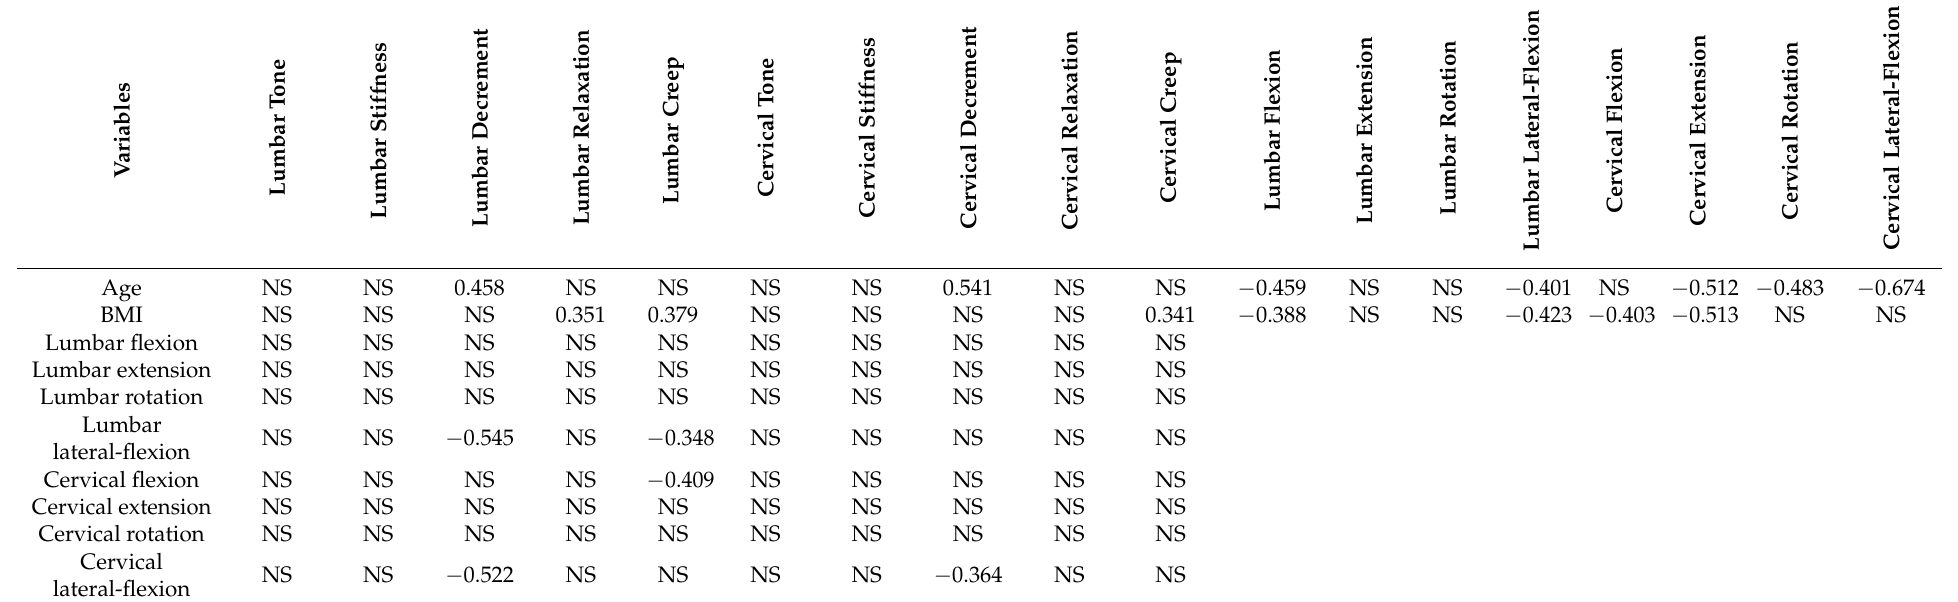
Table 4. Correlations between sociodemographic and clinical characteristics within the acute neck pain